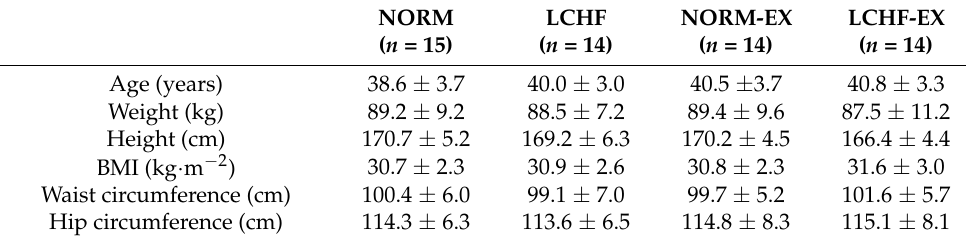
Table 1. Baseline